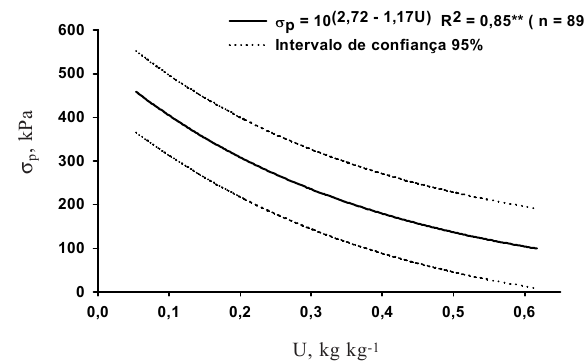
Figura 2. Modelo da capacidade de suporte de carga para o Latossolo Amarelo distrófico típico nas camadas de 0–3, 10–13 e 25–28